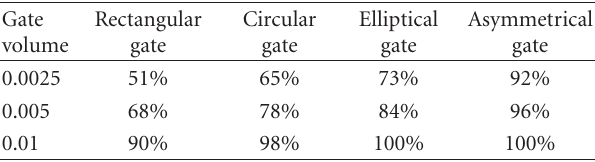
Table 1: Comparison results between circular gate, elliptical gate, rectangular gate and asymmetrical gate for di ff erent gate